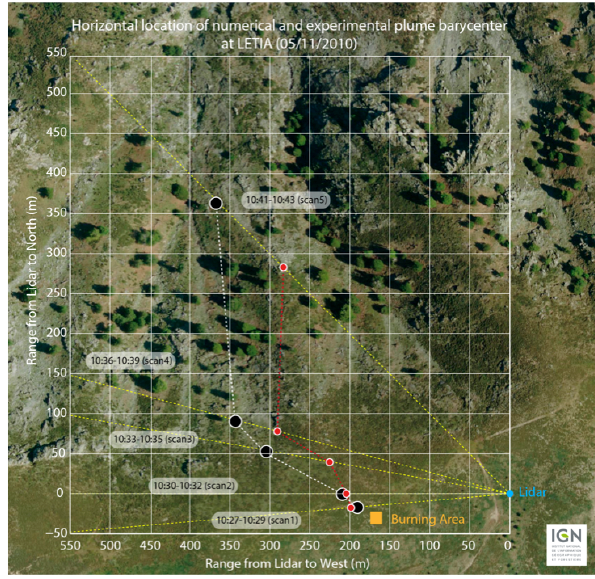
Fig. 11. As Fig. 9 but for horizontal